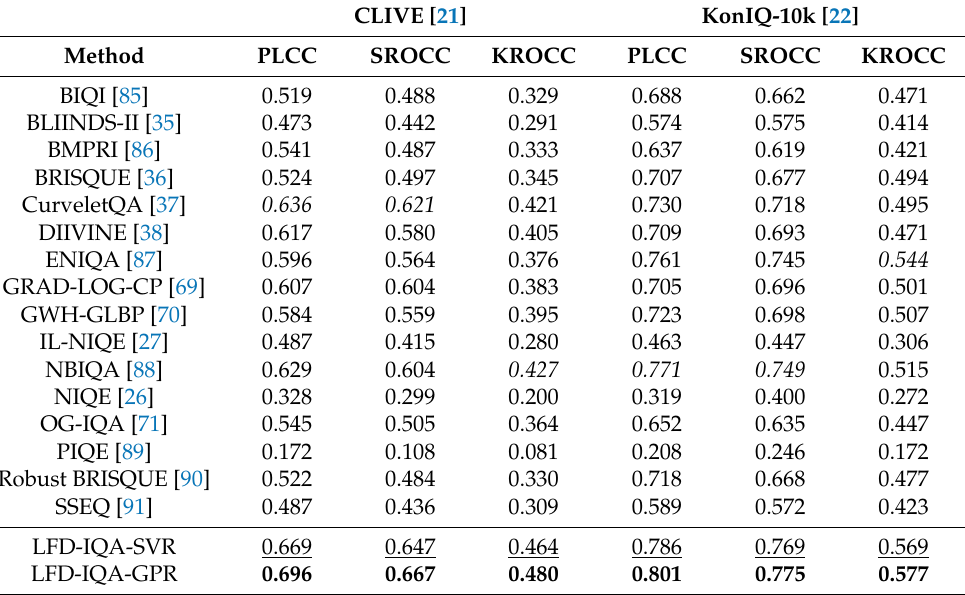
Table 2. Comparison to the state-of-the-art on CLIVE [21] and KonIQ-10k [22] databases. Median PLCC, SROCC, and KROCC values were measured over 100 random train-test splits. The best results are typed in bold, the second best results are underlined, and the third best results are typed in italic.